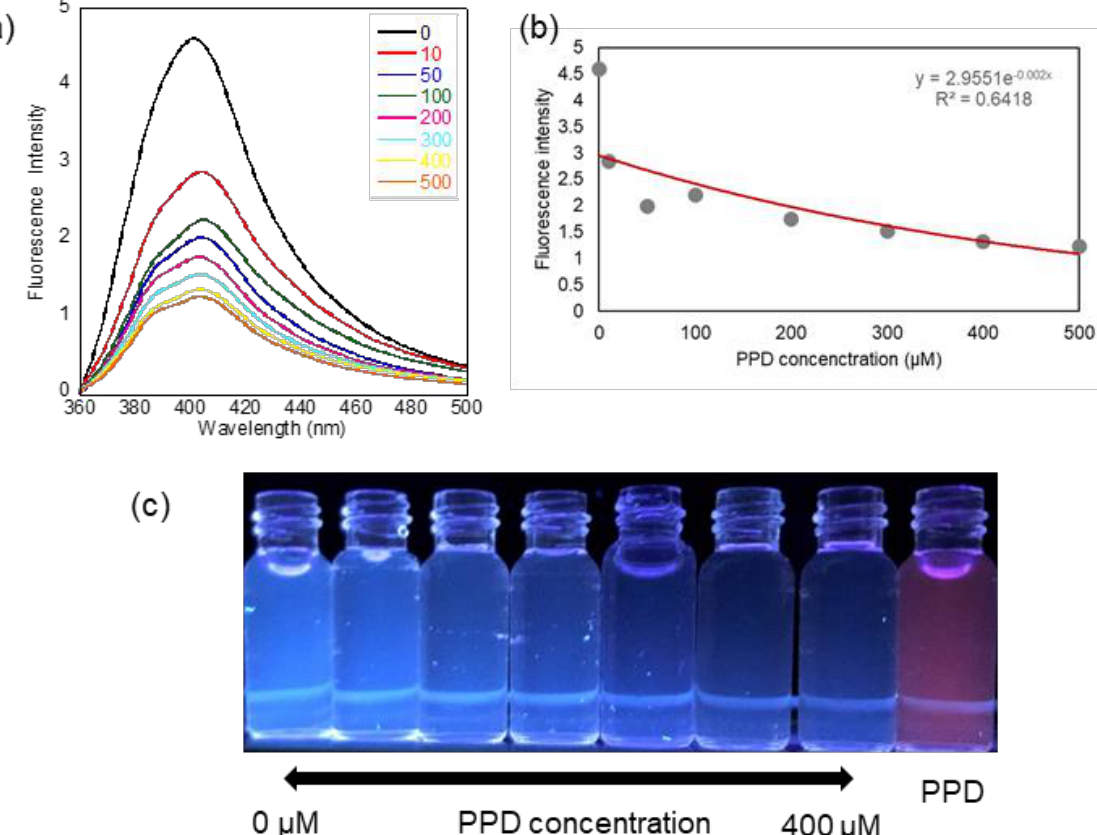
Figure 6. ( a ) Fluorescence spectra in H 2 O (conc. = 0.1 mg/mL, λ abs = 340 nm), ( b ) I 402 plots, and ( c ) photographs of NP(Fl) after the addition of PPD, with concentration ranging from 0 to 400 µM, and the PPD solution.